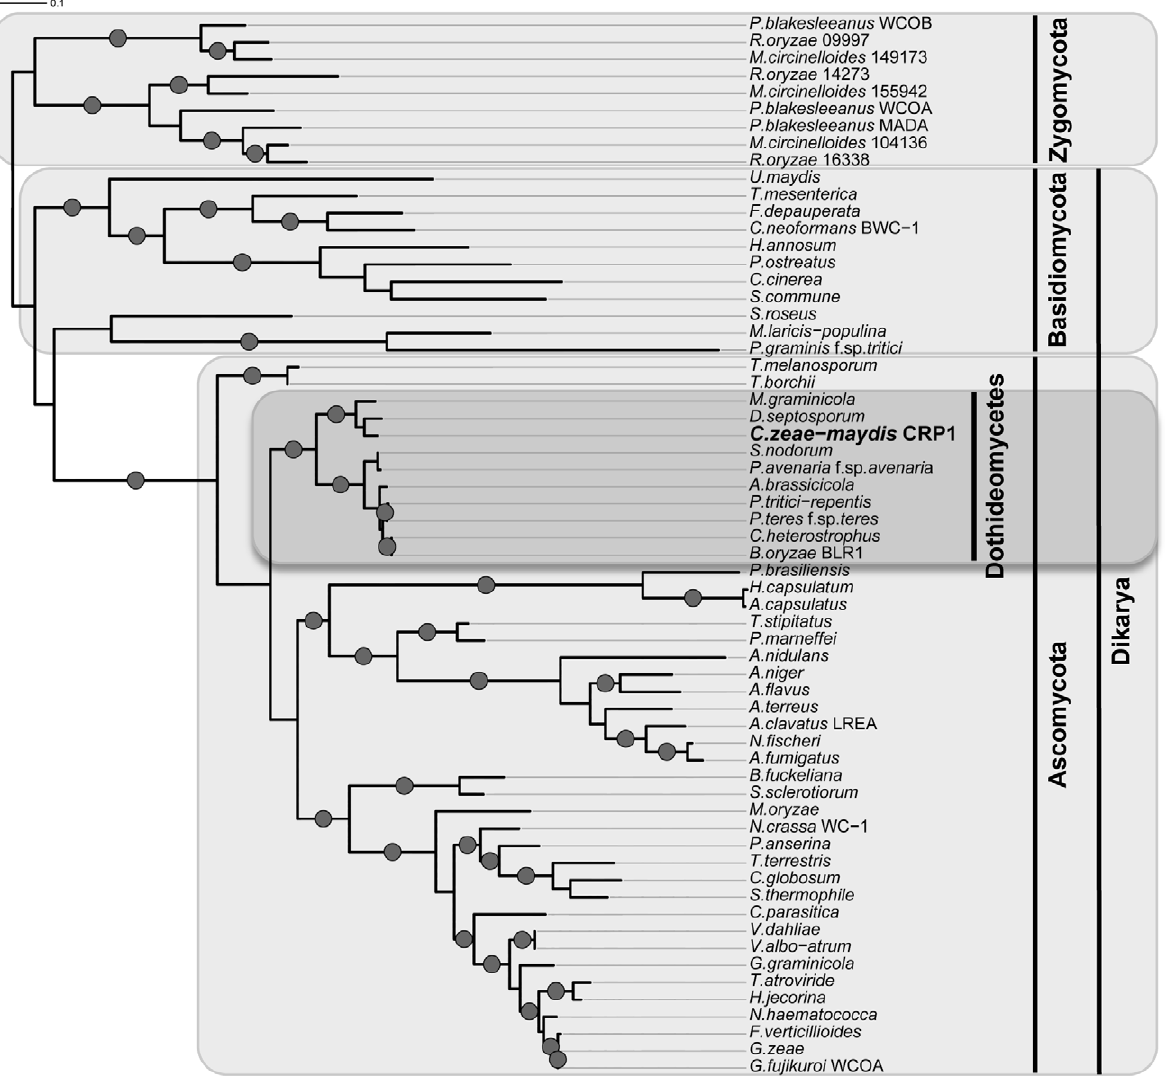
Figure 4. Phylogenetic analysis of Crp1-like proteins. Maximum likelihood tree inferred from Crp1-like proteins within the Zygomycota and the fungal subkingdom Dikarya. RAxML ML bootstrap values are represented by solid dots at each node where the value is above 80%.